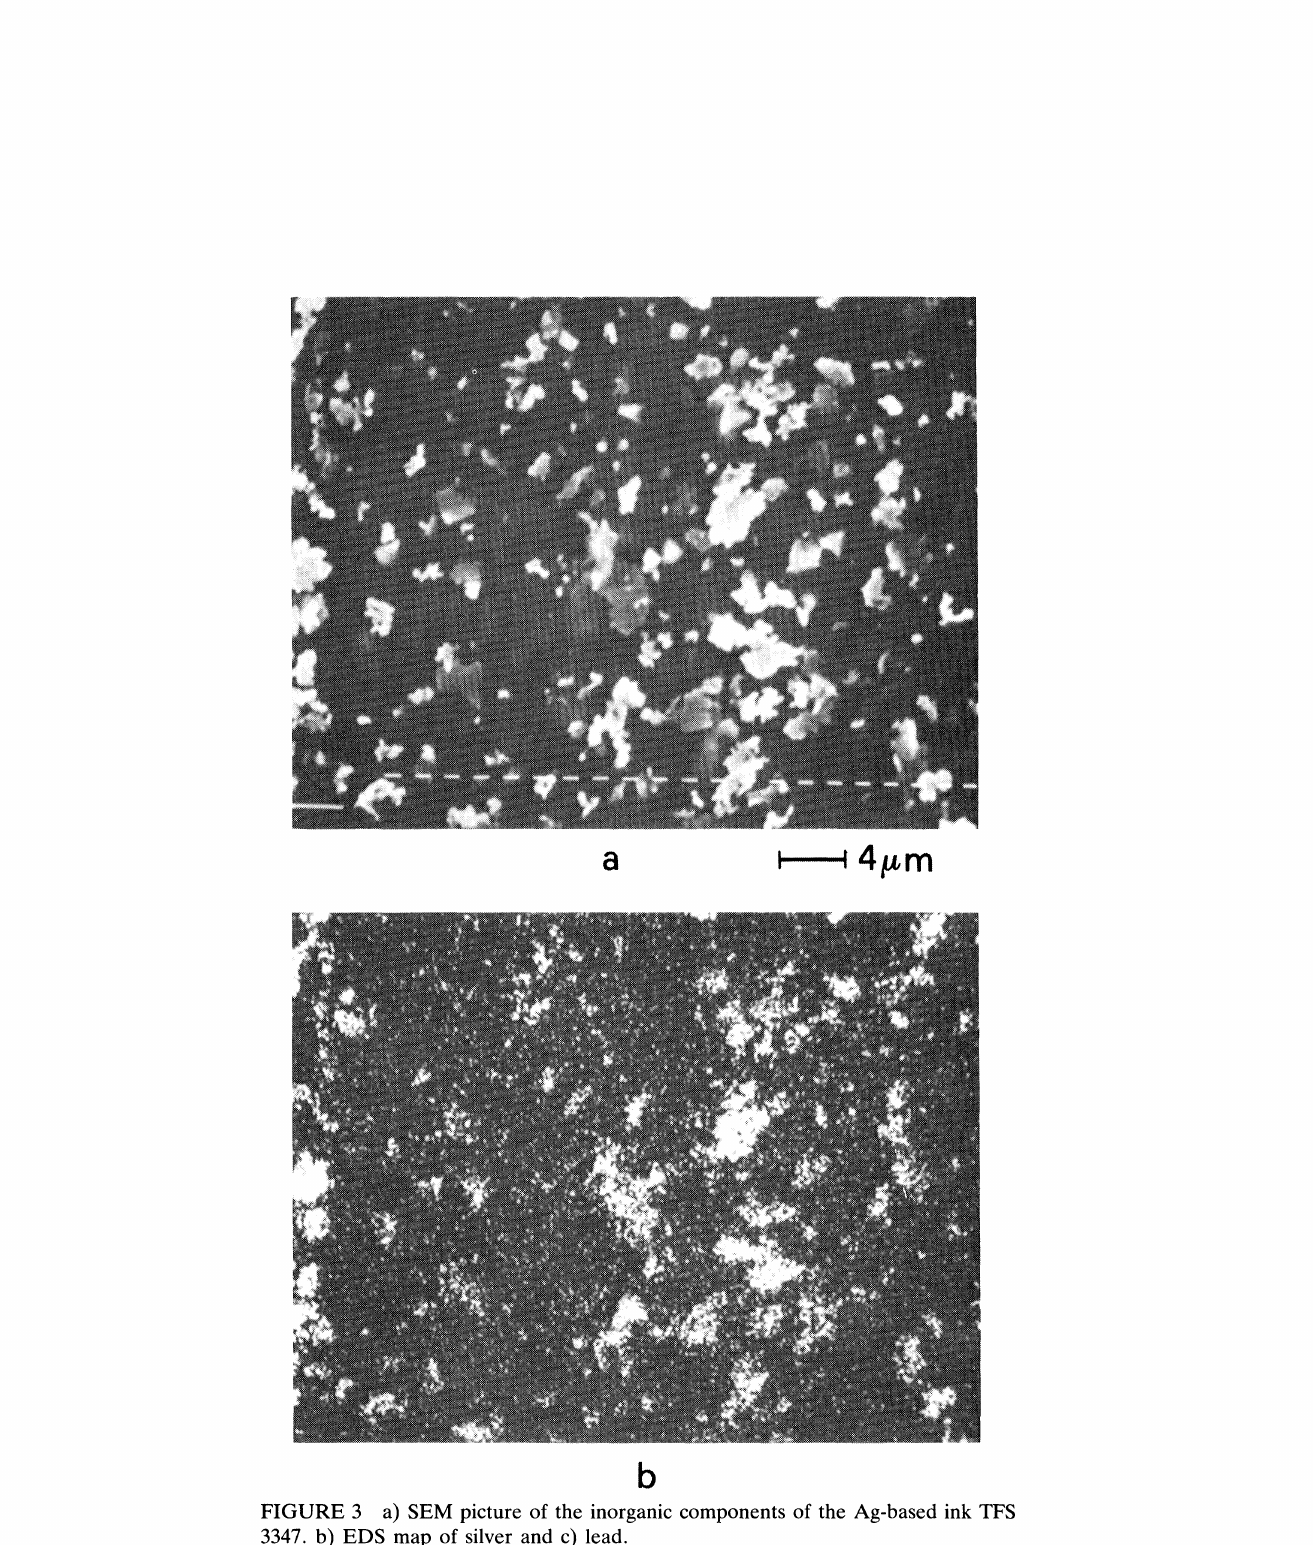
FIGURE 3 a) SEM picture of the inorganic components of the Ag-based ink TFS 3347. b) EDS map of silver and c)